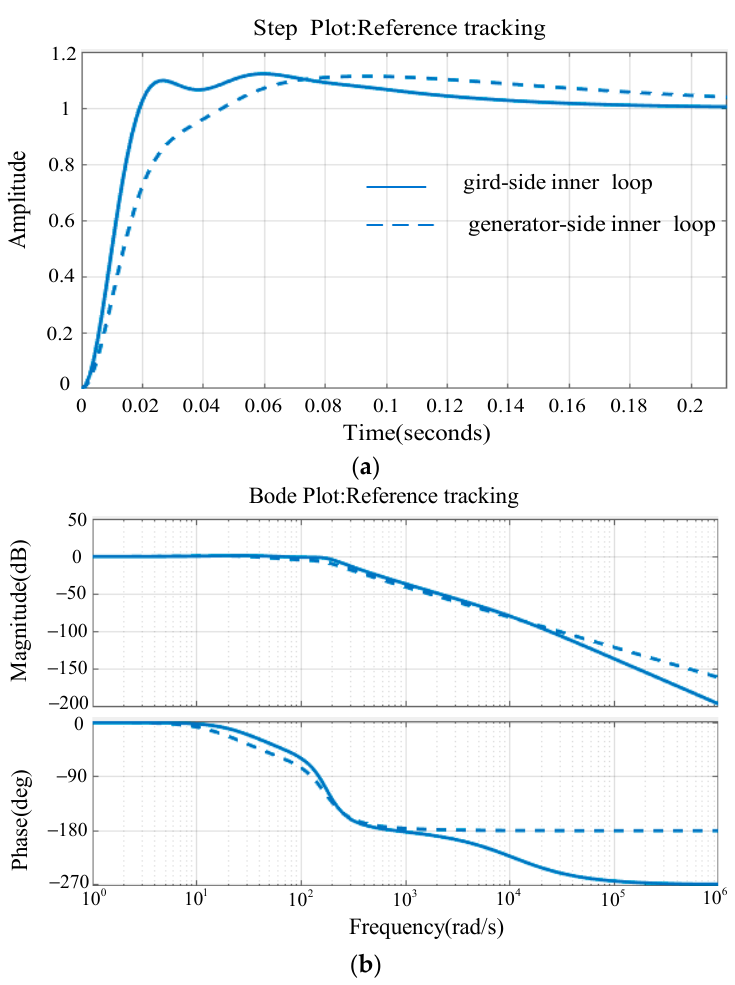
Figure 5. ( a ) The step response curves and ( b ) The Bode plots of the systems with different inner loops.